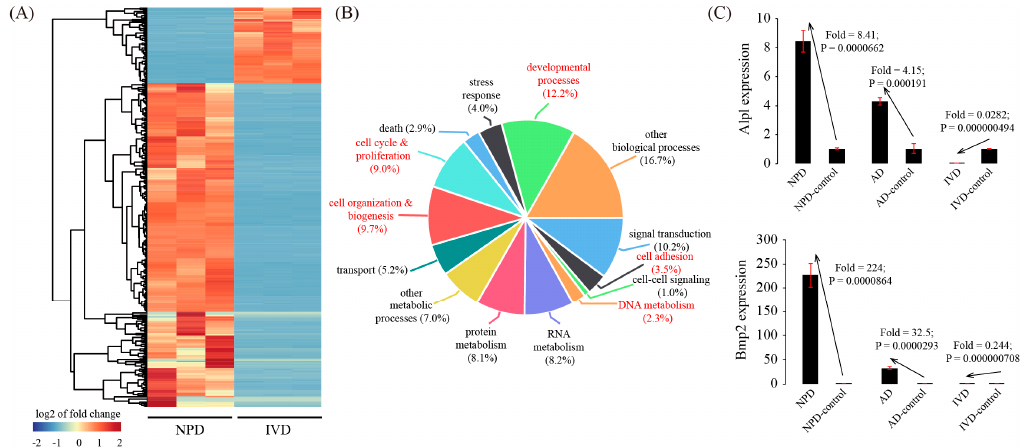
Figure 7. Inconsistently expressed genes in in vitro decidualization (IVD) model compared to NPD. ( A ) Cluster dendrogram of inconsistently expressed genes. The average linkage clustering algorithm with the Pearson correlation distance measure was used. ( B ) GO enrichment analysis of inconsistently expressed genes. ( C ) Validation of representative inconsistently expressed genes by using qRT-PCR. Data were plotted as mean ± SEM. n = 3.